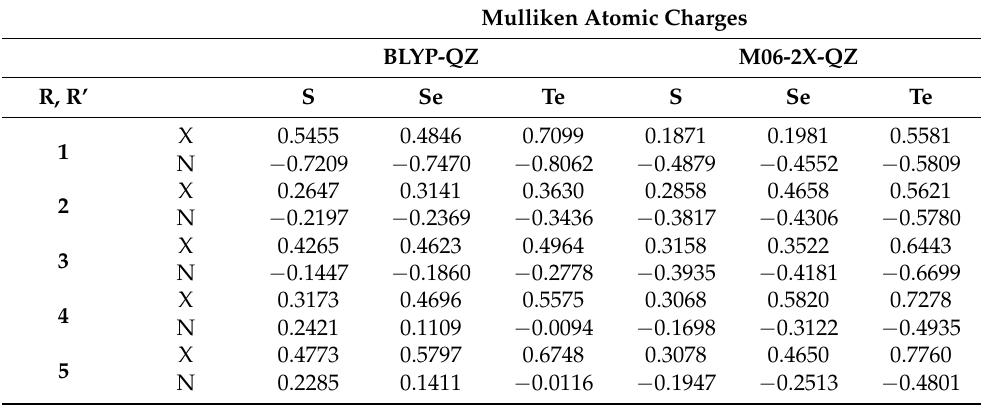
Table 2. Mulliken charges of the investigated compounds. Structure definitions are reported in Figure 1. Levels of theory: